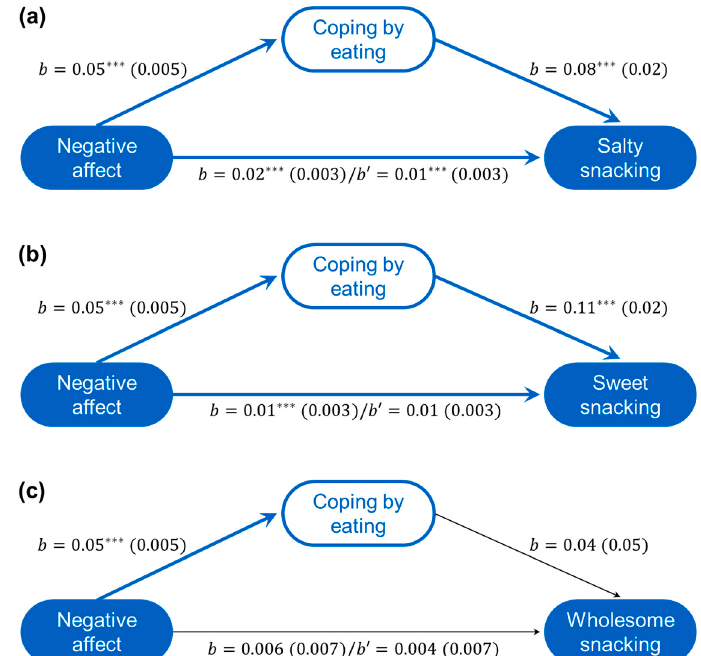
Figure 3. Negative affect predicted coping by eating and unhealthy snacking. Mediated models (unstandardized coefficients ( se )) of the relationships between negative affect and salty ( a ), sweet ( b ), and wholesome snacking ( c ) as mediated through coping by eating (including total effect ( b )/direct effect ( b’ ) between affect and snacking*** p < 0.001.